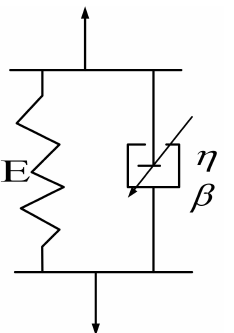
Figure 4. The Conformable Kelvin–Voigt